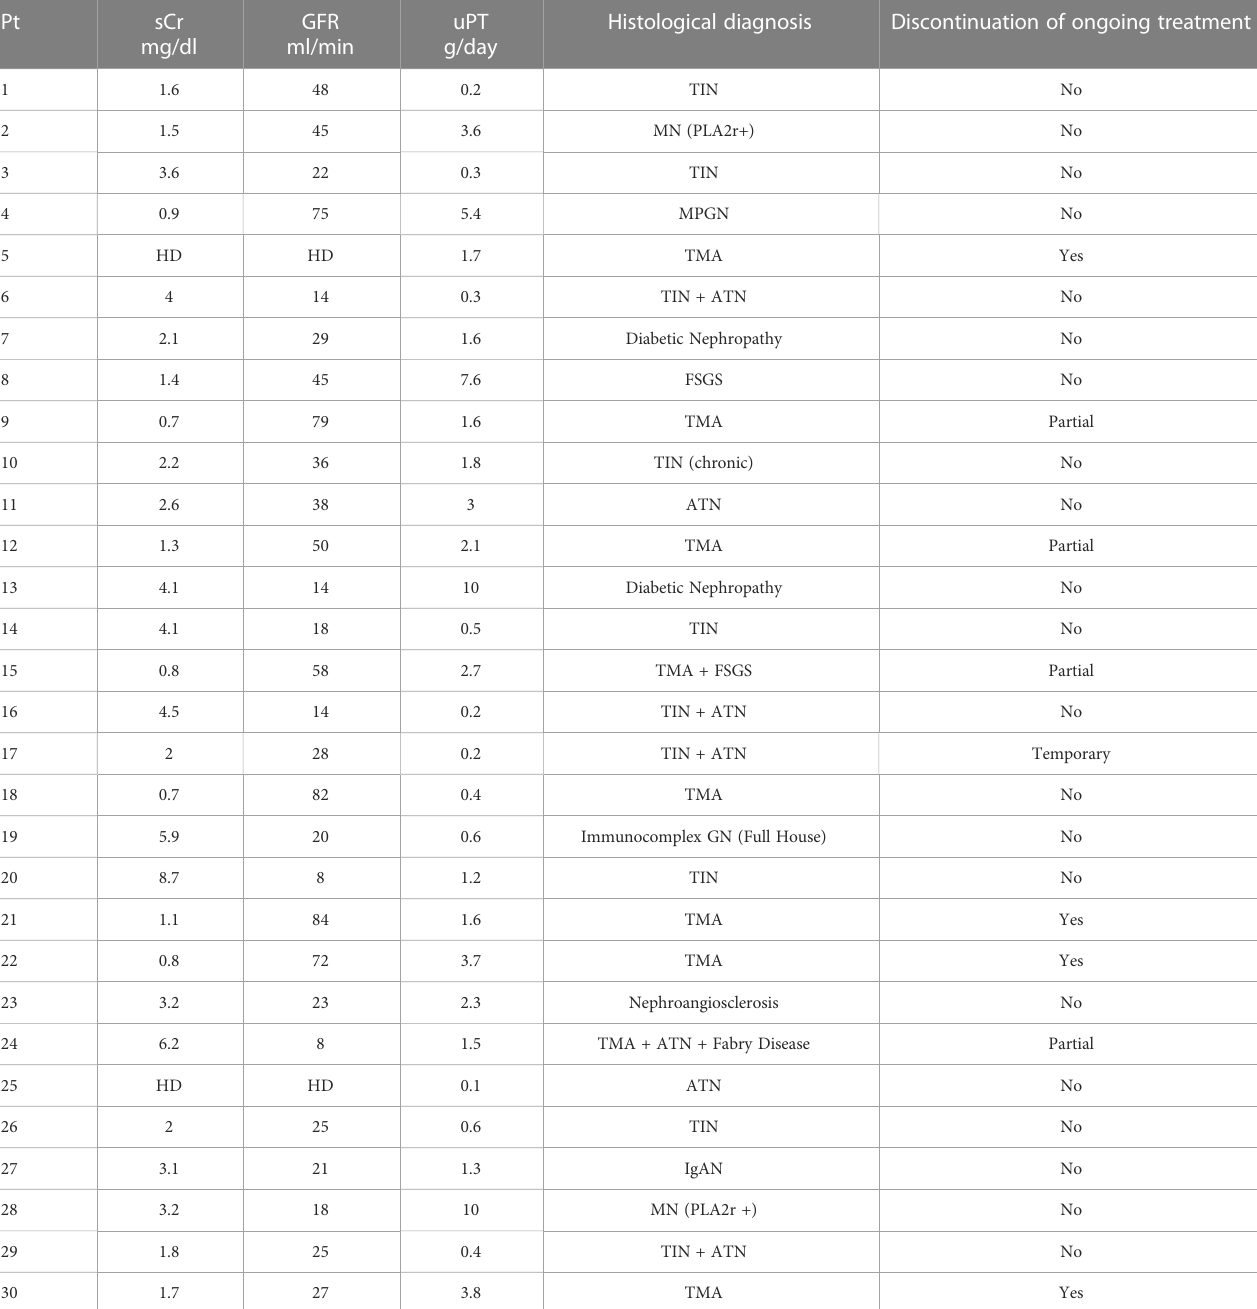
TABLE 2 Clinical characteristics at the time of kidney biopsy, histological fi ndings and indications for continuation/discontinuation of cancer treatment after kidney biopsy. Pt sCr GFR uPT Histological diagnosis Discontinuation of ongoing mg/dl ml/min g/day